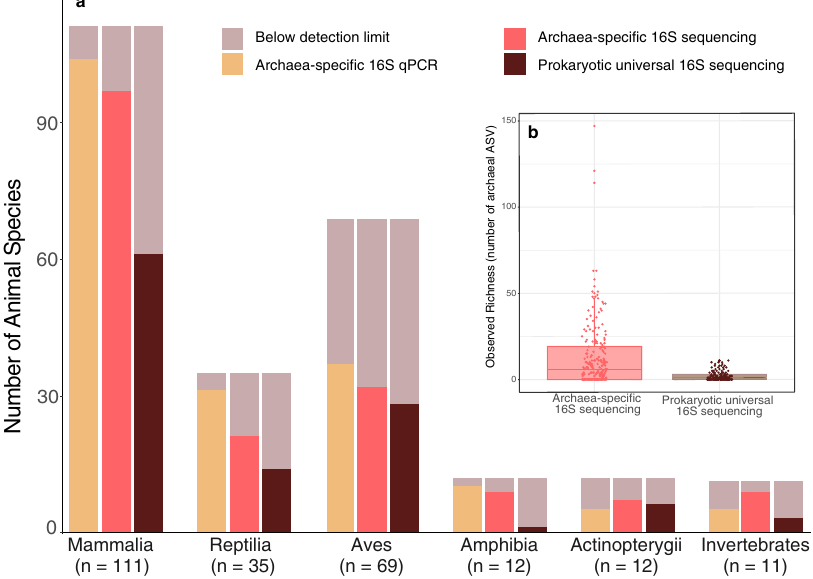
Fig. 1 Detection of archaea in animal species with different approaches. a Presence/absence using qPCR with archaea-speci fi c primers, sequencing with archaea-speci fi c primers and sequencing with prokaryotic universal primers. Invertebrates gather 3 classes (Insecta, Mollusca, and Malacostraca). b Comparison of the number of archaeal ASV in sequencing data using archaea-speci fi c and prokaryotic universal primers ( n = 218 animal species). In the boxplots, the minima is minimum value, maxima is maximum value, center is median and quartiles are shown by box and whiskers, with individual animals shown as colored dots. In total, archaea-speci fi c sequencing identi fi ed 1307 different archaeal ASVs while prokaryotic universal sequencing only identi fi ed 140 different archaeal